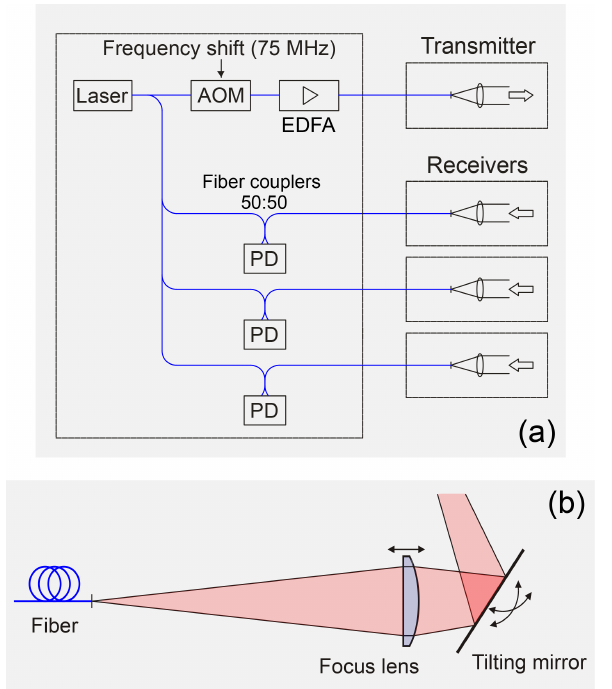
Figure 3. (a) Block diagram of the bistatic lidar system. (b) Sketch of the transmitter and receiver optics. The arrows indicate the motor-controlled degrees of freedom.